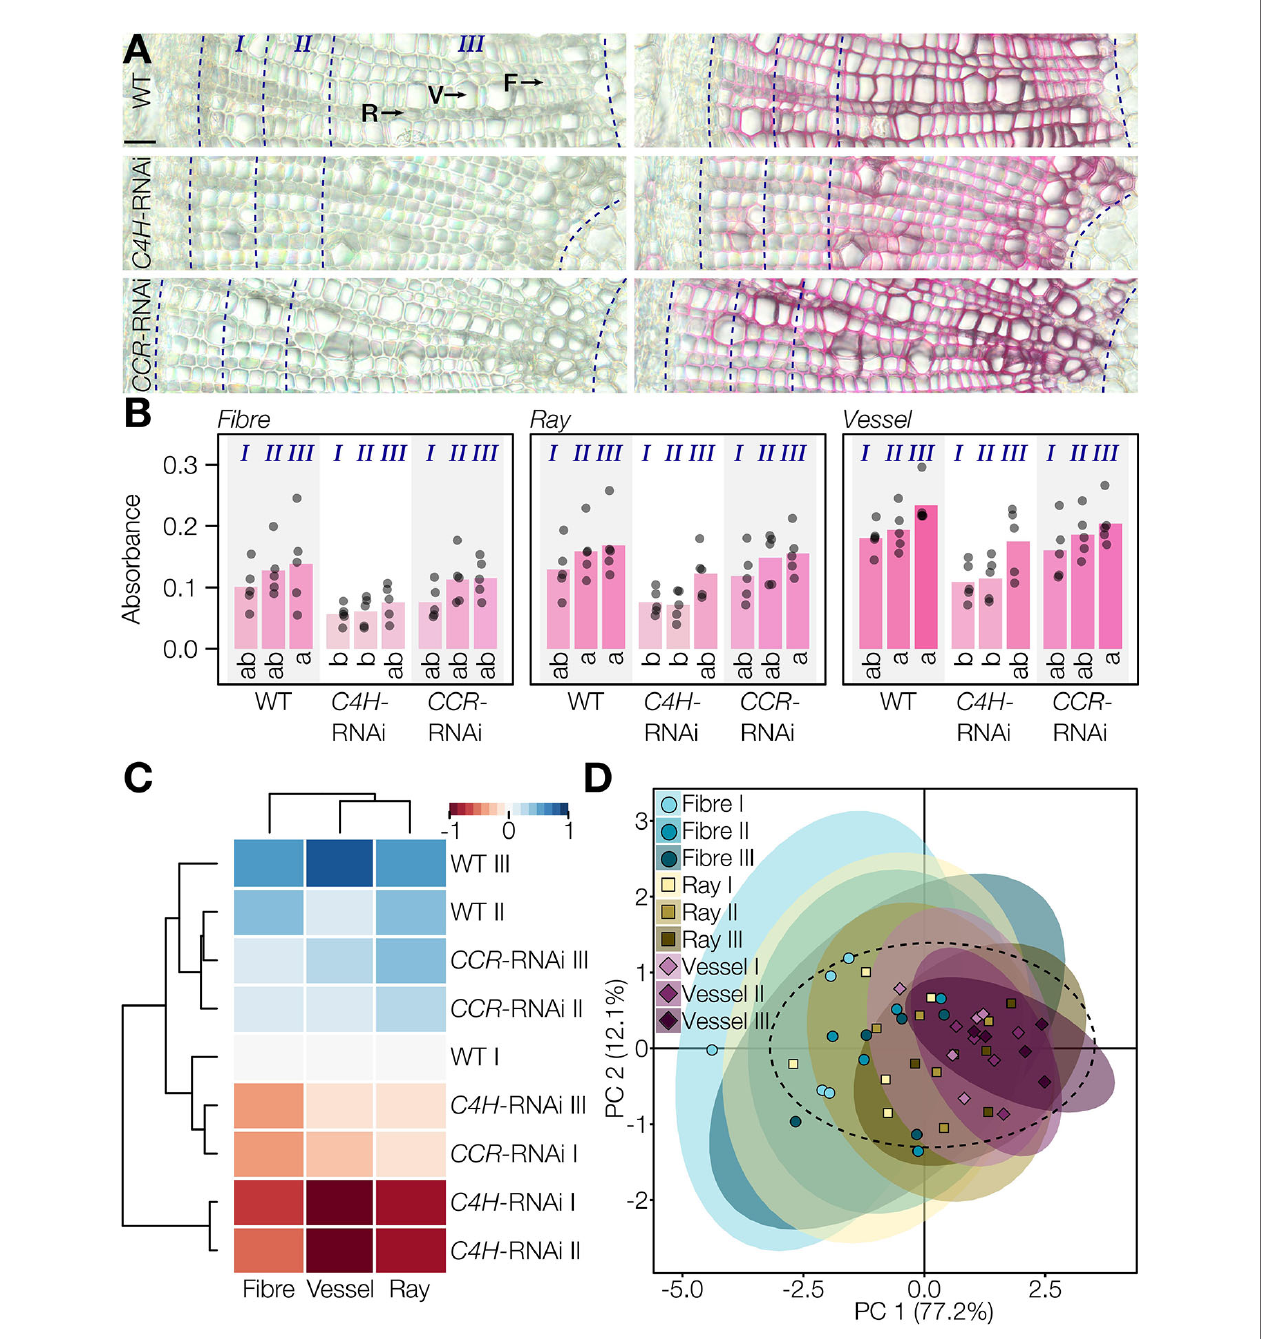
FIGURE 6 | Reaction of the Wiesner test on genetically modi fi ed lignin in poplar. (A) Unstained and 2 min stained transverse cross-sections of poplar WT, C4H - RNAi, and CCR -RNAi plants. Rays (R), vessels (V), and fi bers (F) and xylem developmental stages according to Sundell et al. (2017) are indicated by dotted lines relatively to the cambium. Bars = 25 µm. (B) Changes in absorbance in response to the Wiesner test monitored in the different cell types, genotypes, and along xylem development. Circles indicate the average of each individual replicate and bars represent the average per genotype. The color of bars represents the respective average color of the stain. Quanti fi cation was done on 20 measured points of 5 pixels each per cell type in fi ve individual plants, before binning the points according to their distance to the cambium (I, 0 – 50 µm; II, 50 – 100 µm; III, 100 µm – pith). Letters indicate signi fi cant differences according to a Tukey-HSD test (per panel; a = 0.05). (C) Hierarchical clustering of Wiesner test absorbance in the three ligni fi ed cell types at the three xylem developmental stages in the three genotypes of poplar using the range normalized Euclidean distance of their average difference from the WT. (D) Principal component analysis of the three ligni fi ed cell types at the three xylem developmental stages according to their absorbance in the three tested genotypes; 95% data ellipses are